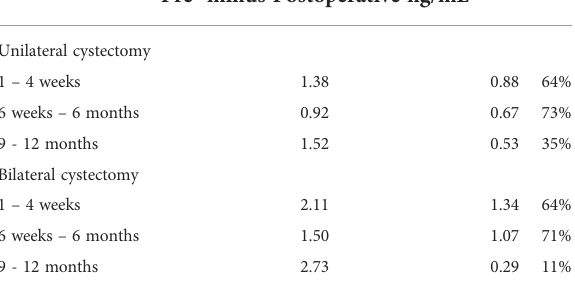
*The coef fi cient of variation (CV) is the ratio of the standard deviation to the mean. The higher the CV, the greater the level of dispersion around the mean. It is expressed as a